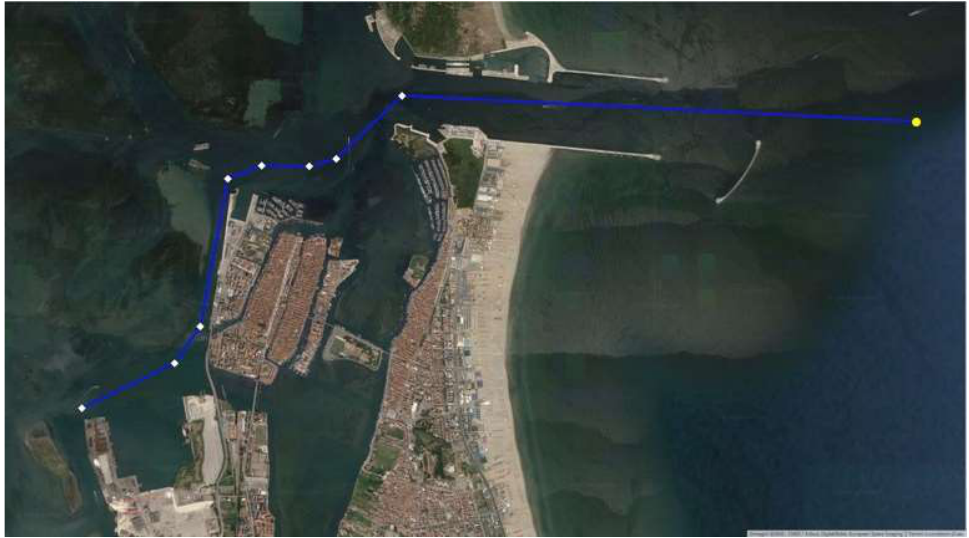
Figure 14. S-AtoN (the first on the right) and V-AtoN in the area of Chioggia.